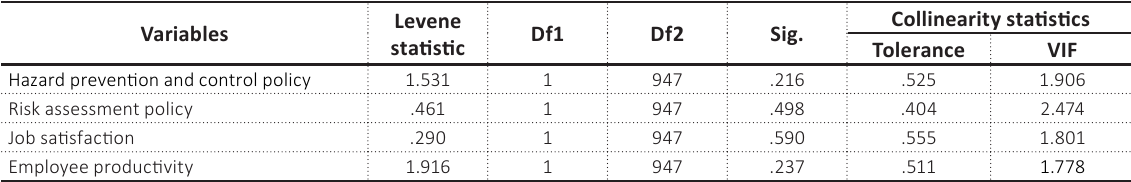
Table 3. Homoscedasticity and multicollinearity